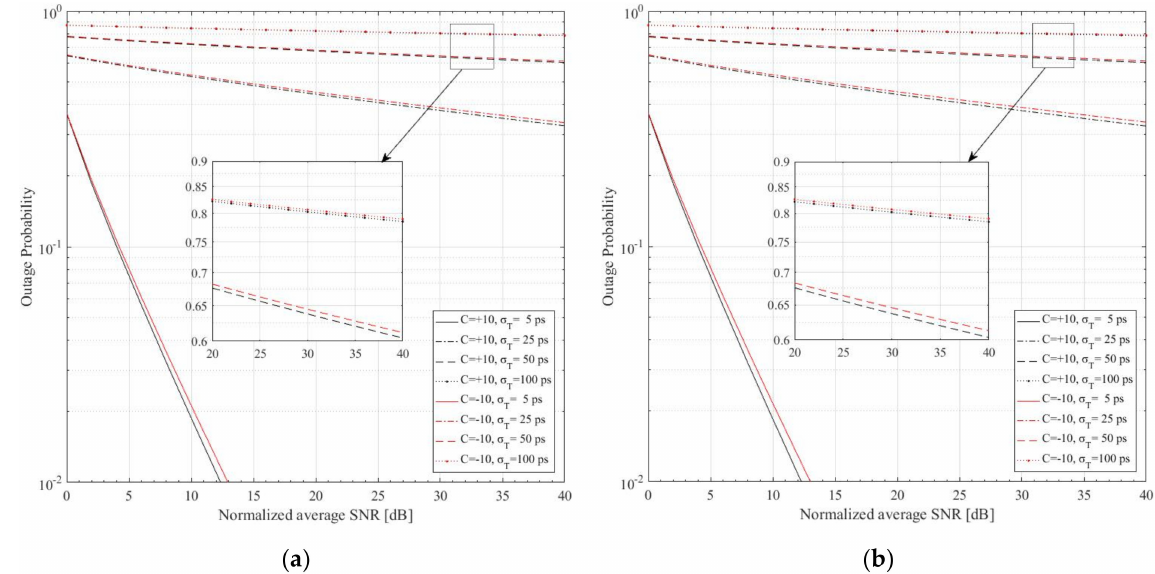
Figure 5. Outage probability of a 100 Mbps link as a function of the normalized average SNR, γ j / γ j , th , with T 0 = 10 ps, as detected after ( a ) 8 km and ( b ) 10 km propagation distance.